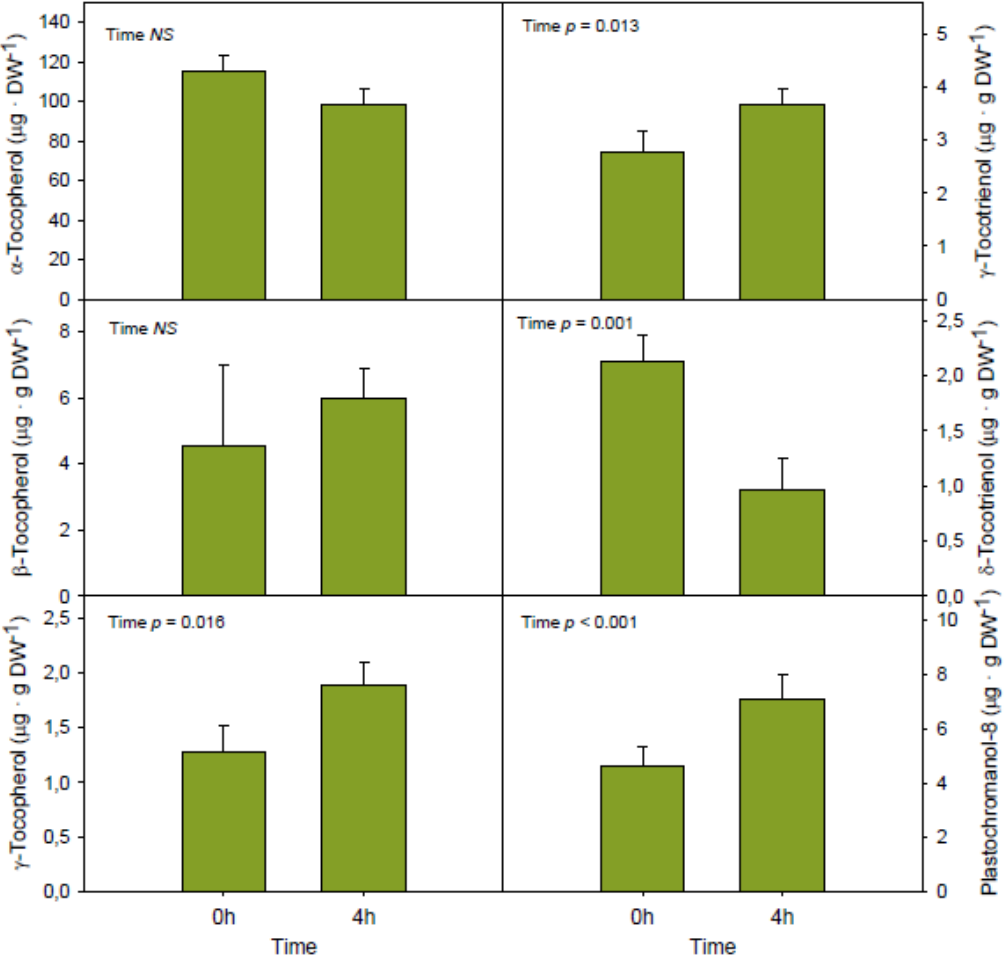
Figure 2. Influence of short-term (4 h) exposure of Bacon avocados to cold temperatures (4 ◦ C) in the contents of tocochromanols. Data represent the mean ± SE of n=18 fruits. Differences were considered significant when p < 0.05. DW, dry weight.